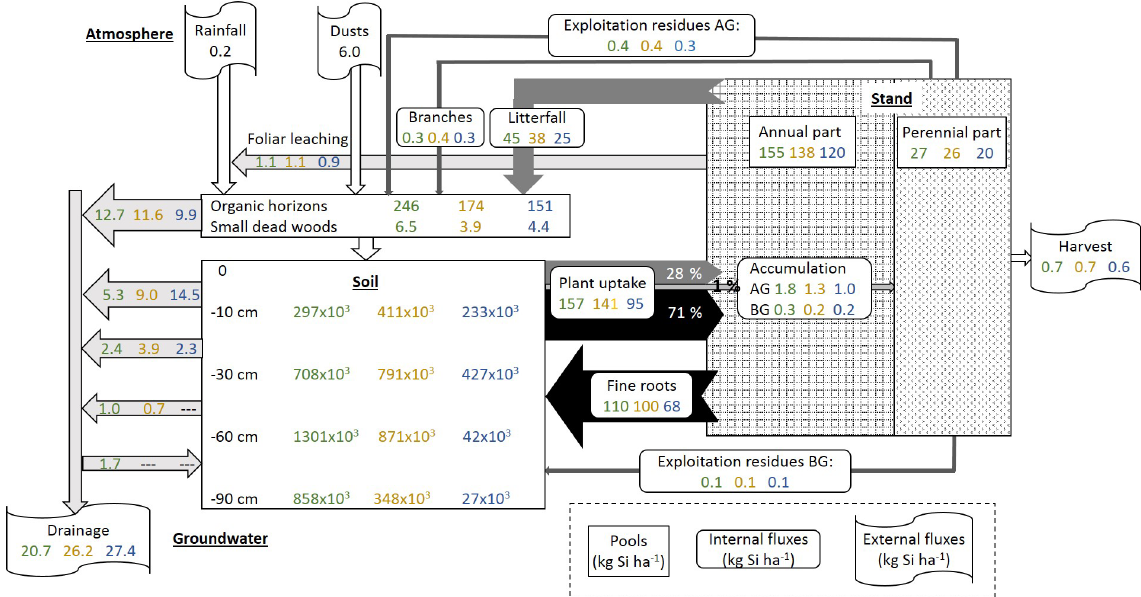
Figure 6. Summary scheme of Si cycling in plots DC, EC and RL at our study forest site, including (i) pools of Si in the biomass, (ii) internal Si fluxes, i.e. in the soil–plant system, (iii) external Si fluxes entering or leaving the soil–plant system and (iv) the DSi budget in the different layers of the ecosystem. Pools are presented by rectangular boxes (tree annual and perennial parts, organic horizons and small dead wood, and soil). Internal fluxes (solid form from the tree to the soil, i.e. fine roots, litterfall including leaves, buds and branches, and exploitation residues; and in solution from the soil to the plant, i.e. the tree uptake) are presented in boxes with rounded edges. Grey/black arrows indicate the direction and the intensity of the internal fluxes. The external fluxes (inputs: rainfall and dust deposits, and outputs: drainage and biomass harvest) are presented in flag boxes. For each pool and flux, values presented are those of the plots DC (in green), EC (in orange) and RL (in blue). The DSi budget in the different layers (forest floor and different soil layers) are represented with white arrows, which indicate the direction and the intensity of the fluxes. Arrows leaving the layer indicate the production of DSi in this layer. In contrast, arrows entering the layer indicate the immobilization of DSi in this layer. Values presented in each box and arrow are annual mean values for plots DC, EC and RL (except for atmosphere values which are similar for the three plots). The AG and BG correspond to above-ground and below-ground tree